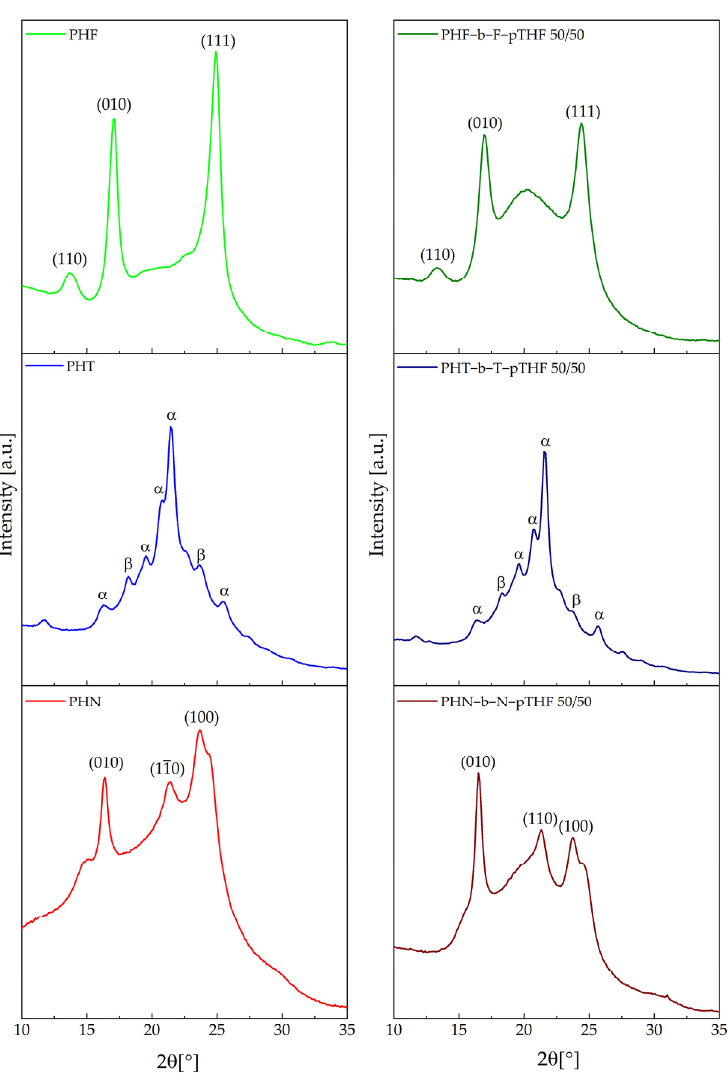
Figure 10. X-ray diffraction (XRD) curves of synthesized polyester and copolymers.